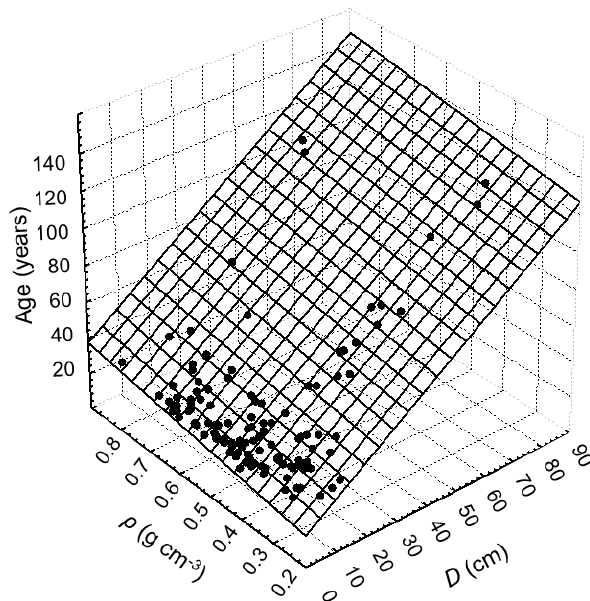
Fig. 5. Multiple regression model predicting tree age as a function of diameter, D , and wood density, ρ , developed by a data set of 117 trees of different successional stages of the wetland forests in the northern Pantanal (Age=8.274+1.2153 · D +28.405 · ρ